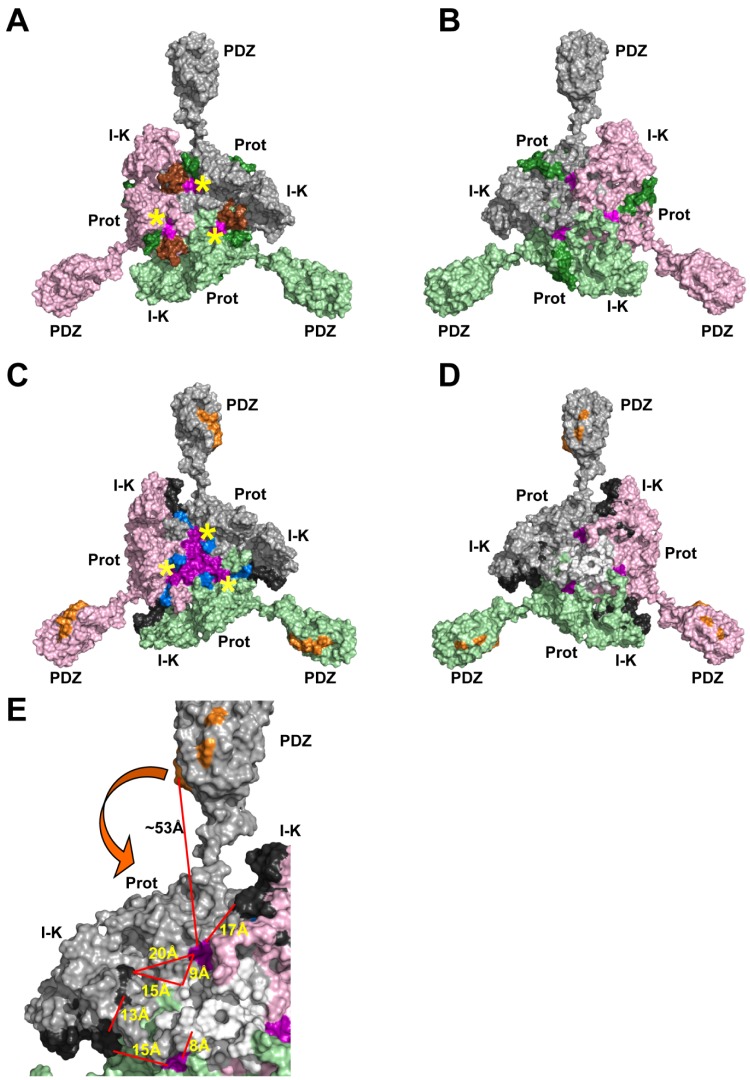
Location of the epitopes for mAbs 9C9 and 6G6.(A) Same view as in Figure 6A & C. The epitope regions for mAb 9C9 are shown: residues 283–297 (colored brown), residues 224–227 (from the 223–242 peptide, colored dark green) and residues 320–322 (from the 308–322 peptide, colored magenta). (B) A +180o rotation about the Y-axis from view shown in panel (A), showing the non-catalytic face of HtrA3. Residues 228–242 are colored dark green and 308–319 are colored magenta. (C) The epitope regions for mAb 6G6 are shown: residues 73–78 (from the 73–92 peptide, colored dark grey), residues 288–302 (colored blue), residues 322–327 (from the 313–327 peptide, colored purple), and residues 398–412 (colored orange). (D) A +180o rotation about the Y-axis from view shown in panel (C), showing the non-catalytic face of HtrA3. Residues 79–92 are colored dark grey and 313–321 are colored purple. The 6G6 epitope residues 133–147 (colored white) are now visible on the protease domain surface. (E) Close up view of panel (D) showing the 6G6 epitope regions on the non-catalytic face of HtrA3. Distances between some of the epitope regions are shown in Å. The arrow indicates the direction the PDZ domain would need to move to place the 6G6 epitope residues 398–412 (colored orange) in closer to the residues 313–321 (colored purple), 133–147 (colored white) and 79–92 (colored dark grey). In panels (A) and (C), the location of the catalytic site in each monomer is indicated by a yellow asterix.